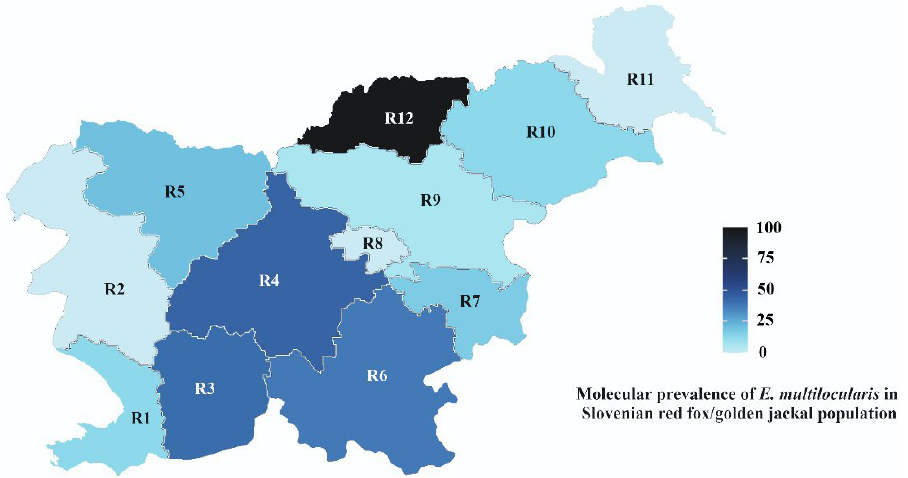
Figure 1. Molecular prevalence of E. multilocularis in the Slovenian red fox/golden jackal population (%). Regions (R): R1—obalno kraska, R2—goriska, R3—primorsko notranjska, R4—osrednjeslovenska, R5—gorenjska, R6— jugovzhodna Slovenija, R7—posavska, R8—zasavska, R9—savinjska, R10—podravska, R11—pomurska, R12—koroska.